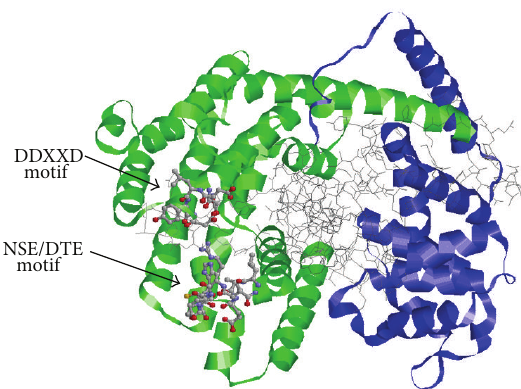
Figure 3: Predicted 3D model of PmSTS generated by the I-TASSER server. The two conserved domains are highlighted. The N-terminal domain is in blue and the C-terminal domain is in green. Both aspartate-rich motifs are displayed using ball and stick representation with CPK colour. The wire bonds represent the rest of the